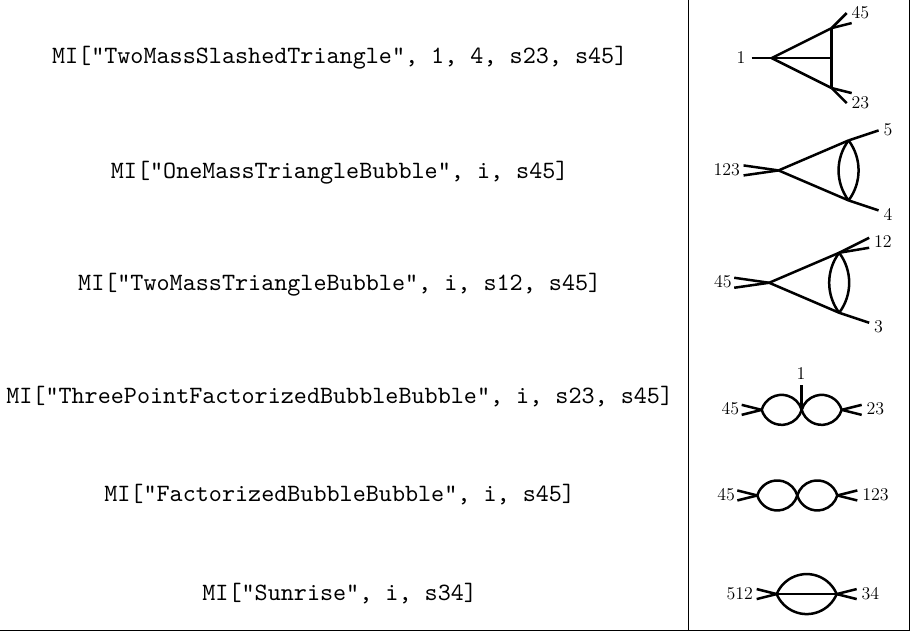
Table 11. Permutation representatives for two- and three-point two-loop master integral topolo-